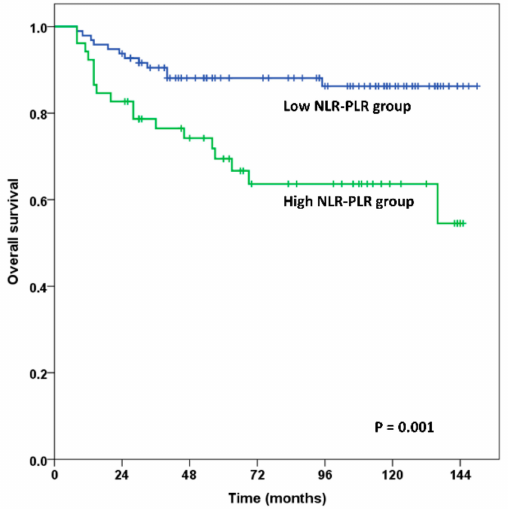
Figure 1. Overall survival estimation using Kaplan–Meier analysis. The 5- and 10-year overall survival rates for the high NLR-PLR group vs. the low NLR-PLR group were 69.4% and 63.6% vs. 88.1% and 86.2% ( p = 0.001).